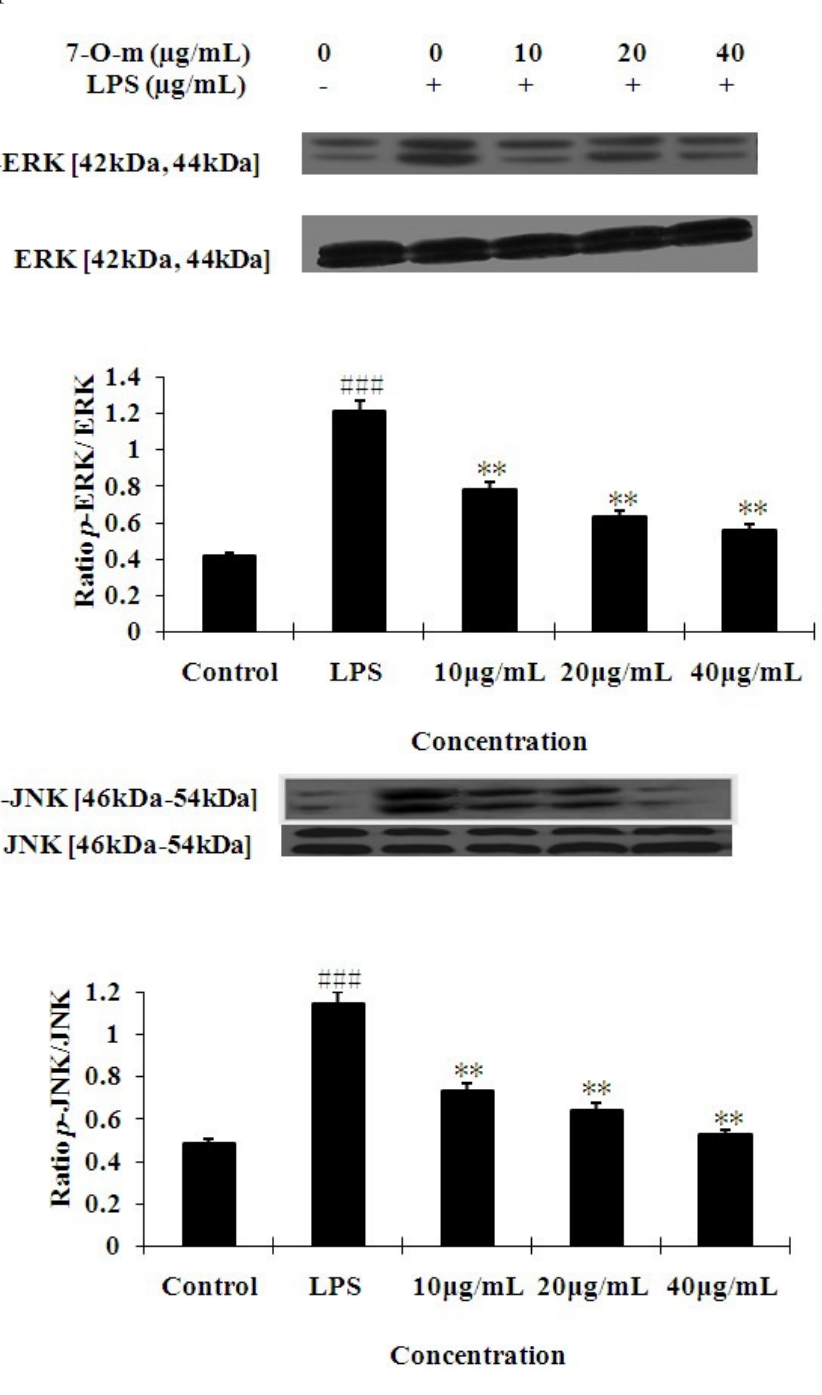
Figure 4. Effects of 7- O -methylnaringenin (7- O -m) on MAPK in LPS-stimulated RAW 264.7 cells. The cells were pretreated with different concentrations (10, 20, 40 µ g/mL) of 7- O -methylnaringenin for 1 h and then incubated with or without 1 µ g/mL of LPS for 30 min. Protein samples were analyzed by Western blot with phospho-specific antibodies as described in materials and methods. The data are representative of three independent experiments and expressed as mean ± SEM. ** P < 0.01 vs . LPS group. ### P < 0.001 vs . control